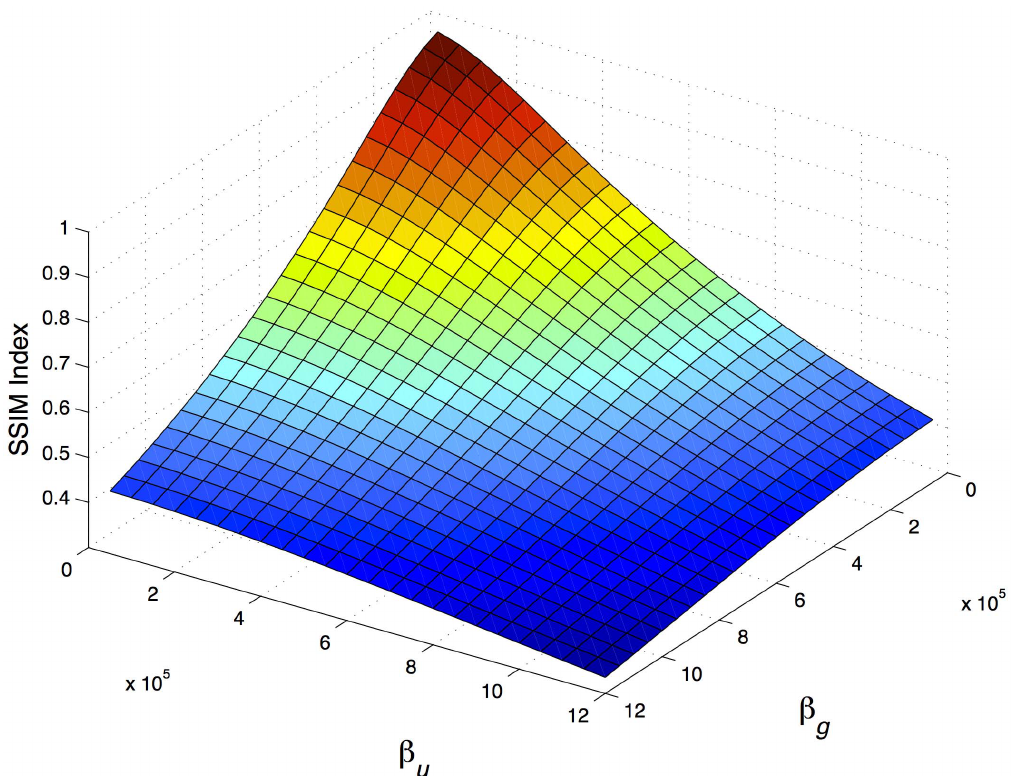
Figure 2. Similarity between an original document and its fingerprinted copy as the energy assigned to users ( b u ) and groups( b g ) vary, with fixed values of fingerprint length ( L ) and insertion position ( P w ). High SSIM Index values implies a high similarity. doi:10.1371/journal.pone.0081976.g002 circumstances or geographic location. Under this assumption, a hierarchical fingerprinting technique based on spread spectrum has been proposed. Using this technique, users are assigned to